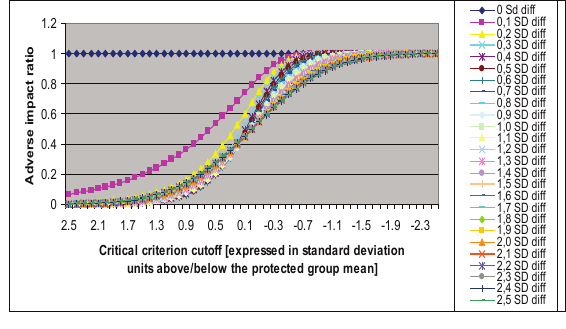
FIGURE 1 Adverse impact ratio as a function of the criterion cut-off in the protected group predicted criterion distribution and the difference in the mean predicted criterion performance: expressed in standard deviation units [ρ XY =0,30]